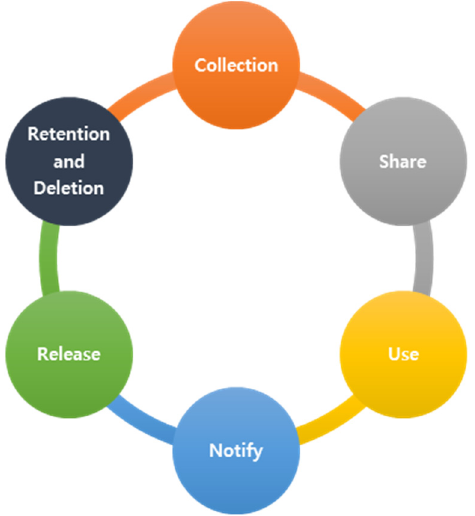
Figure 4. Data processing steps of the centralized contact tracing system.